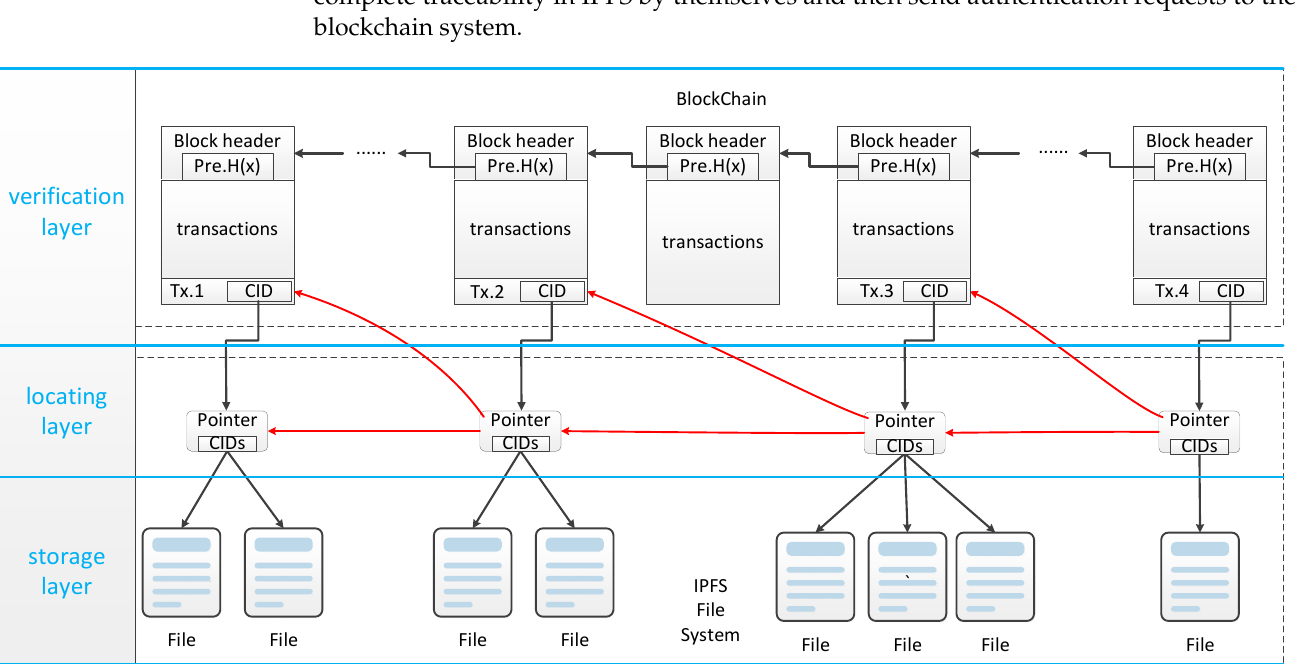
Figure 3. The three-layer interactive traceability structure supporting type filtering.